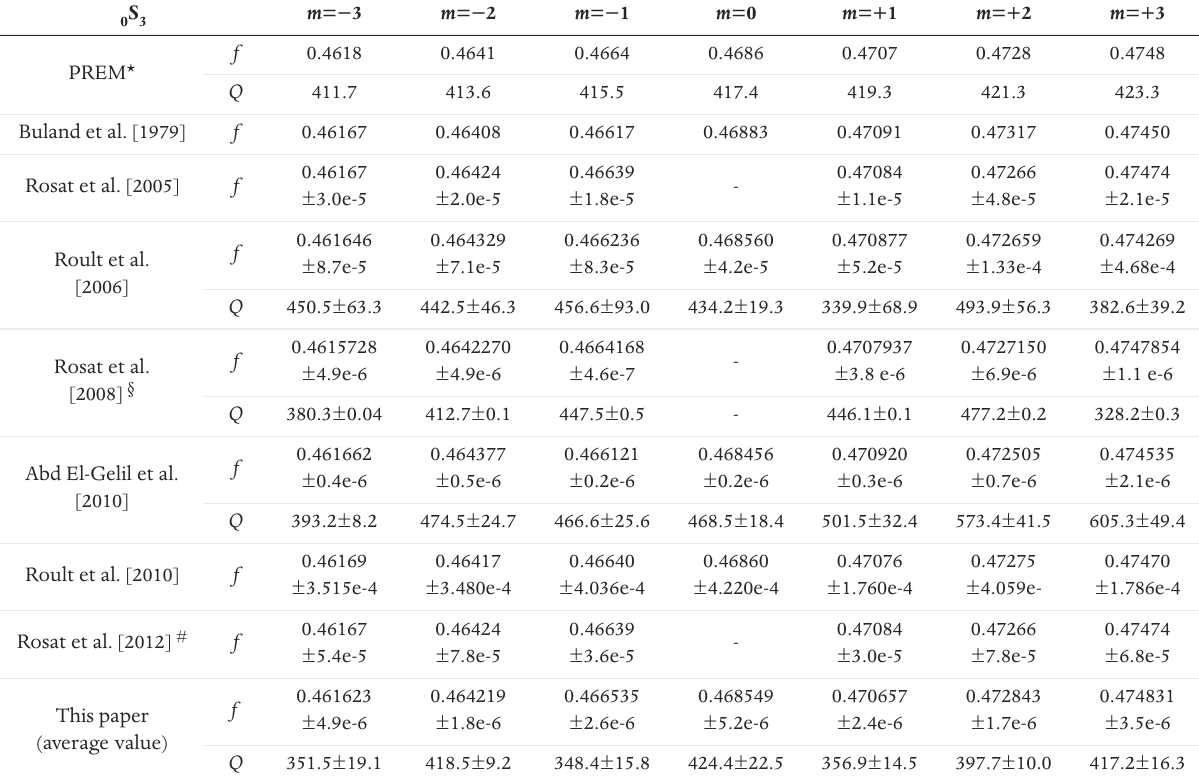
S . (*): from Millot-Langet et al. [2003], Rosat et al. [2008]. 0 3